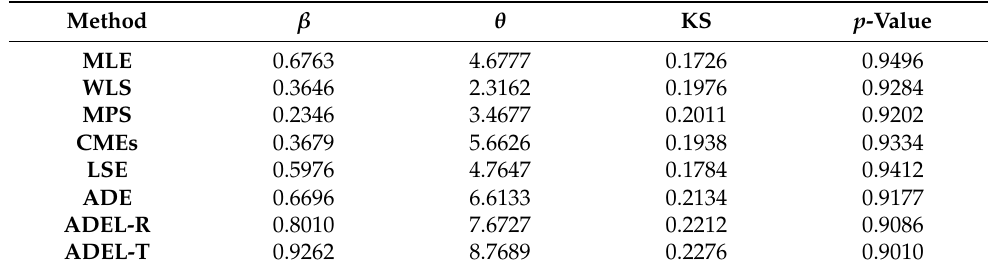
Figure 9. The density, TTT, P–P, and Q–Q plots of the PZD for the failure times data. Table 4 represents the values of the parameter estimators for the hypothesized distri- bution PZD obtained by the different methods, and Kolmogorov–Smirnov (KS) and the corresponding p -values. Because n = 50 > 30, it is established by the simulation study that the MLE methods give the best results. Table 4. Different parameter estimators for failure times data.